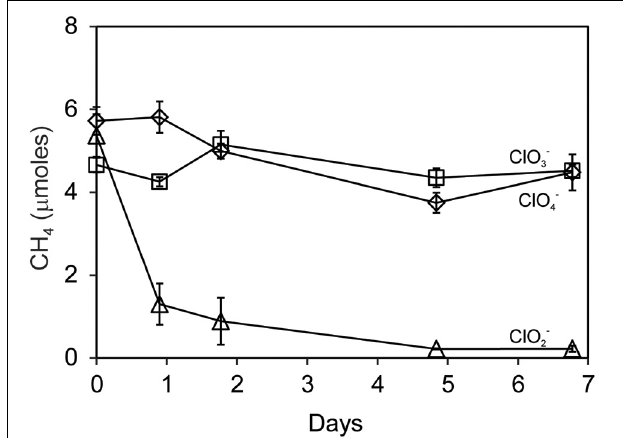
FIGURE 7 | Methane uptake by Searsville Lake soils during anaerobic incubations with D. agitata CKB following addition of ClO − 2 (triangles), ClO − 4 (diamonds), or ClO − 3 (squares). Symbols represent the mean and standard deviation of triplicate measurements. Absence of bars indicates that the error is smaller than the symbol